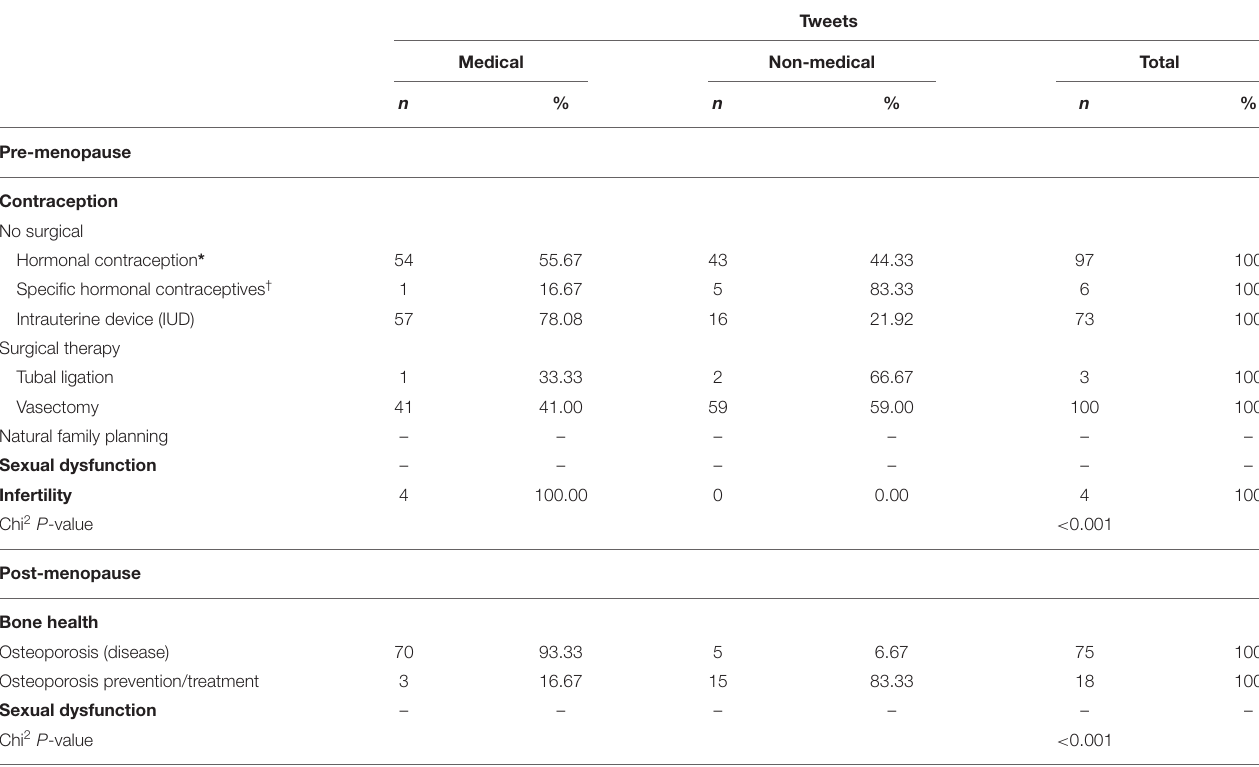
TABLE 4 | Number of tweets generated in pre-menopause and post-menopause classified by medical and non-medical